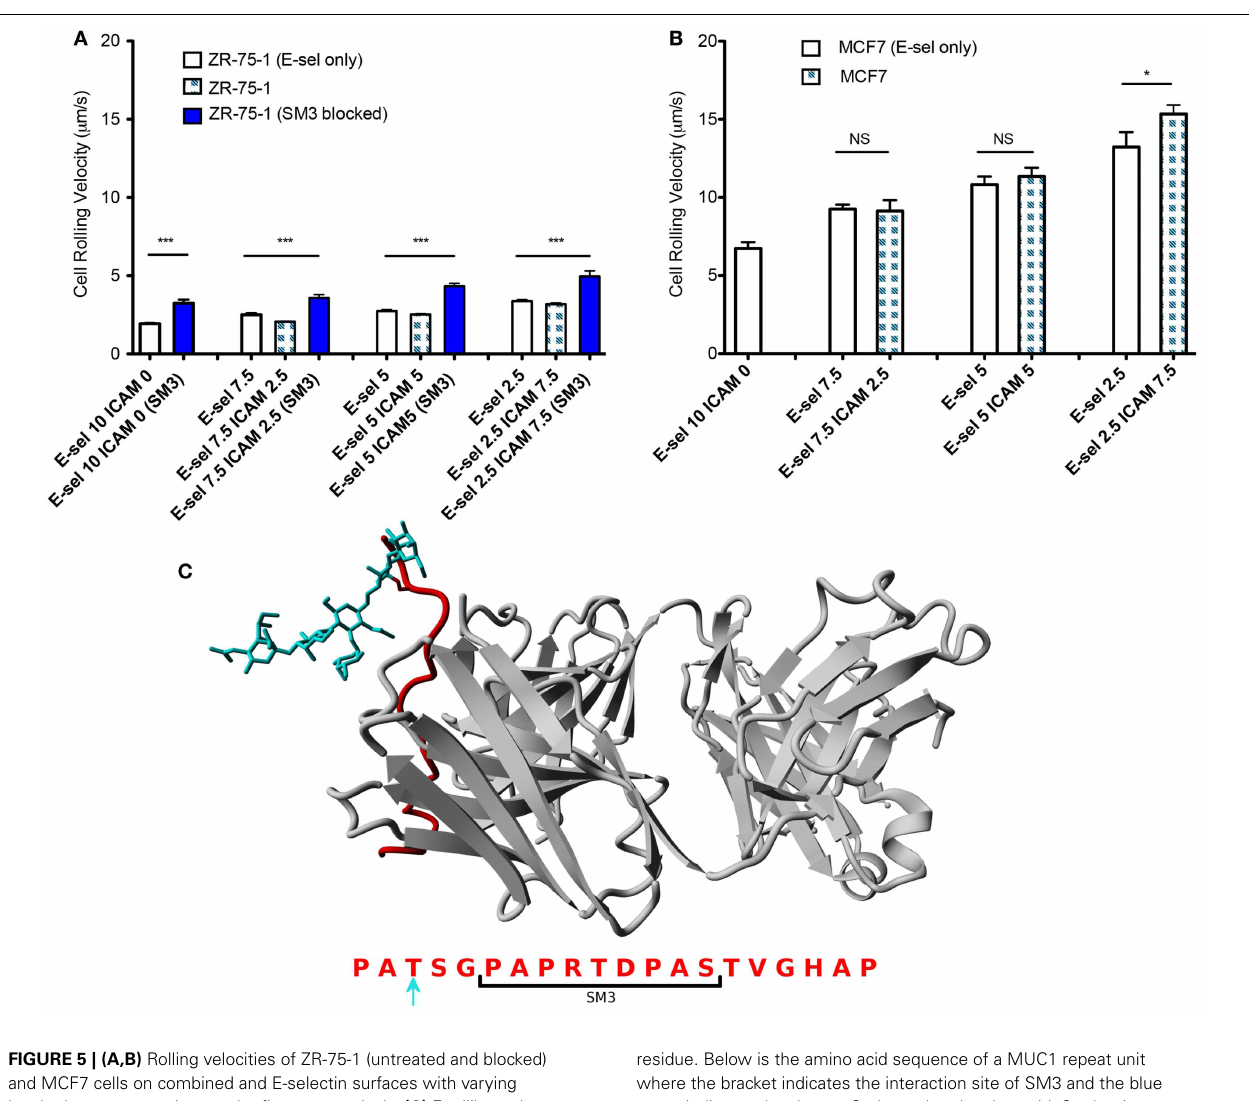
FIGURE 5 | (A,B) Rolling velocities of ZR-75-1 (untreated and blocked) and MCF7 cells on combined and E-selectin surfaces with varying incubation concentrations under flow, respectively. (C) Equilibrated structure of SM3 (gray) bound to the core epitope of one repeat unit of MUC1 (red) singly O-glycosylated with sLe x (blue) on a threonine